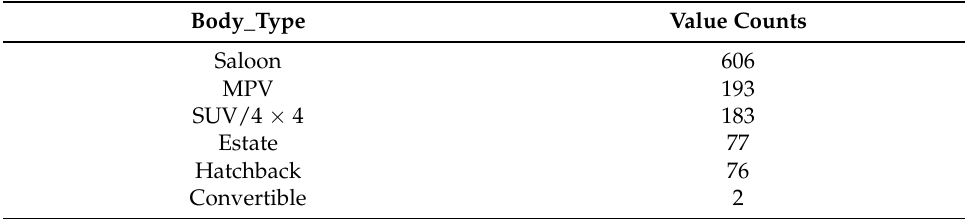
Table 3. Value counts of feature body type.